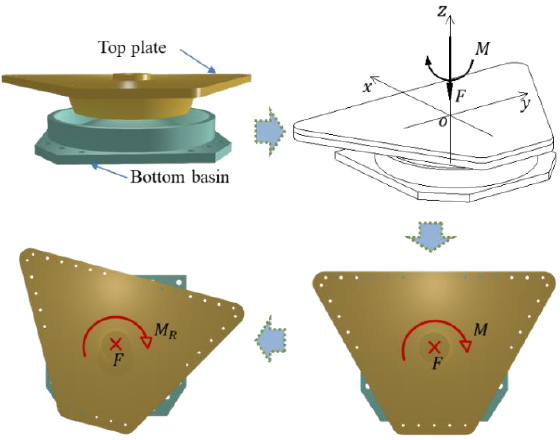
Figure 2. The rotation model of the UHS.